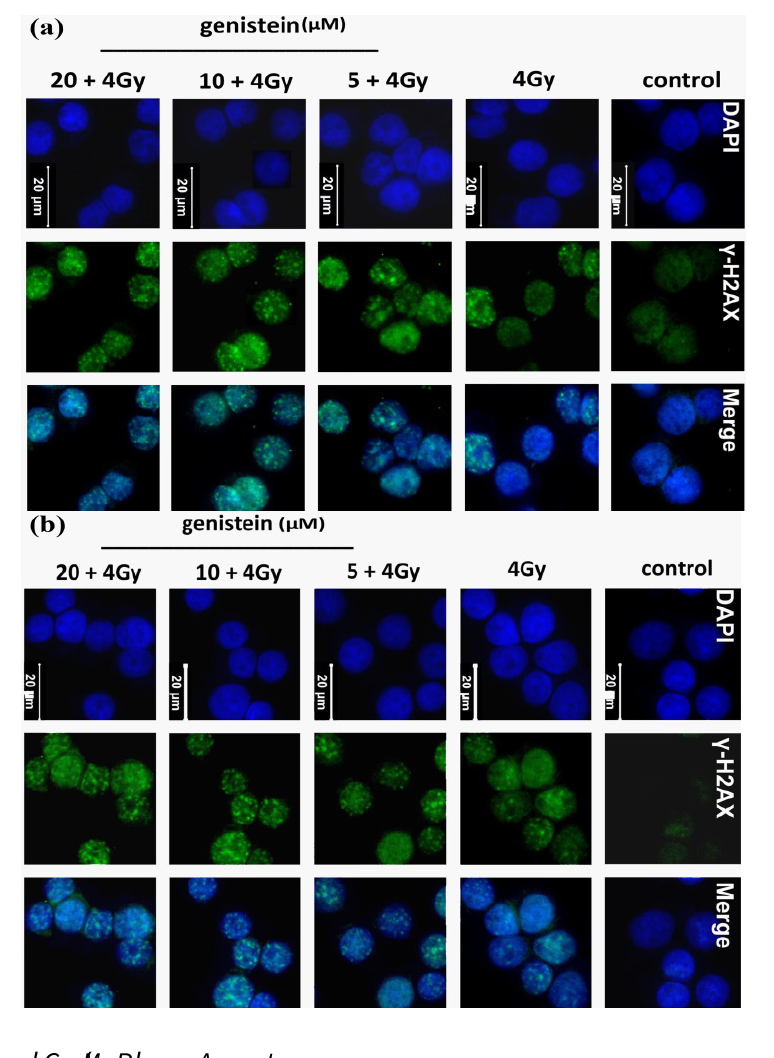
Figure 4. Effect of genistein combined with X-ray irradiation on the DNA damage of MCF-7 (a) and MDA-MB-231 cells (b). Nuclear staining was done with DAPI (blue) while γ -H2AX staining appeared as green points (foci). Scale bars represent 20 μ